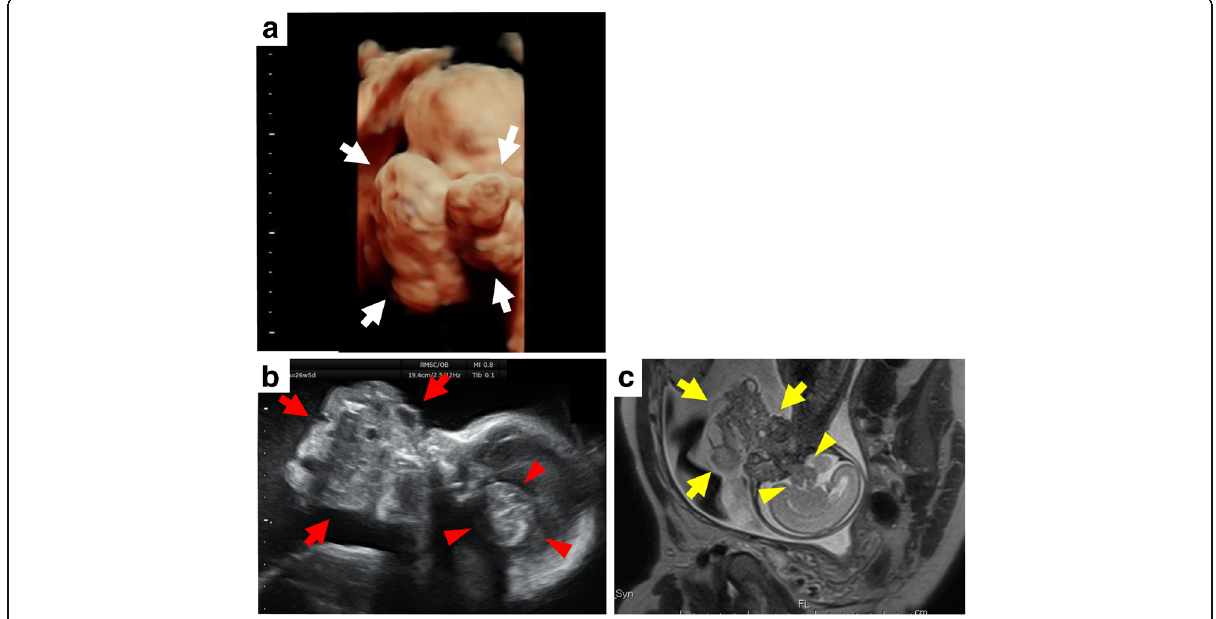
Fig. 1 Ultrasonographic and MRI images. a Three-dimensional ultrasonographic image at gestational week 25 shows a giant tumor around the neck and face (white arrow), strongly suggesting an epignathus. b Ultrasonographic image at gestational week 26 shows a giant tumor around the neck (red arrow), and an intracranial tumorous lesion (red arrowhead). c MRI image at gestational week 25 suggests a connection between the giant tumor around the neck (yellow arrow) and the intracranial tumor (yellow